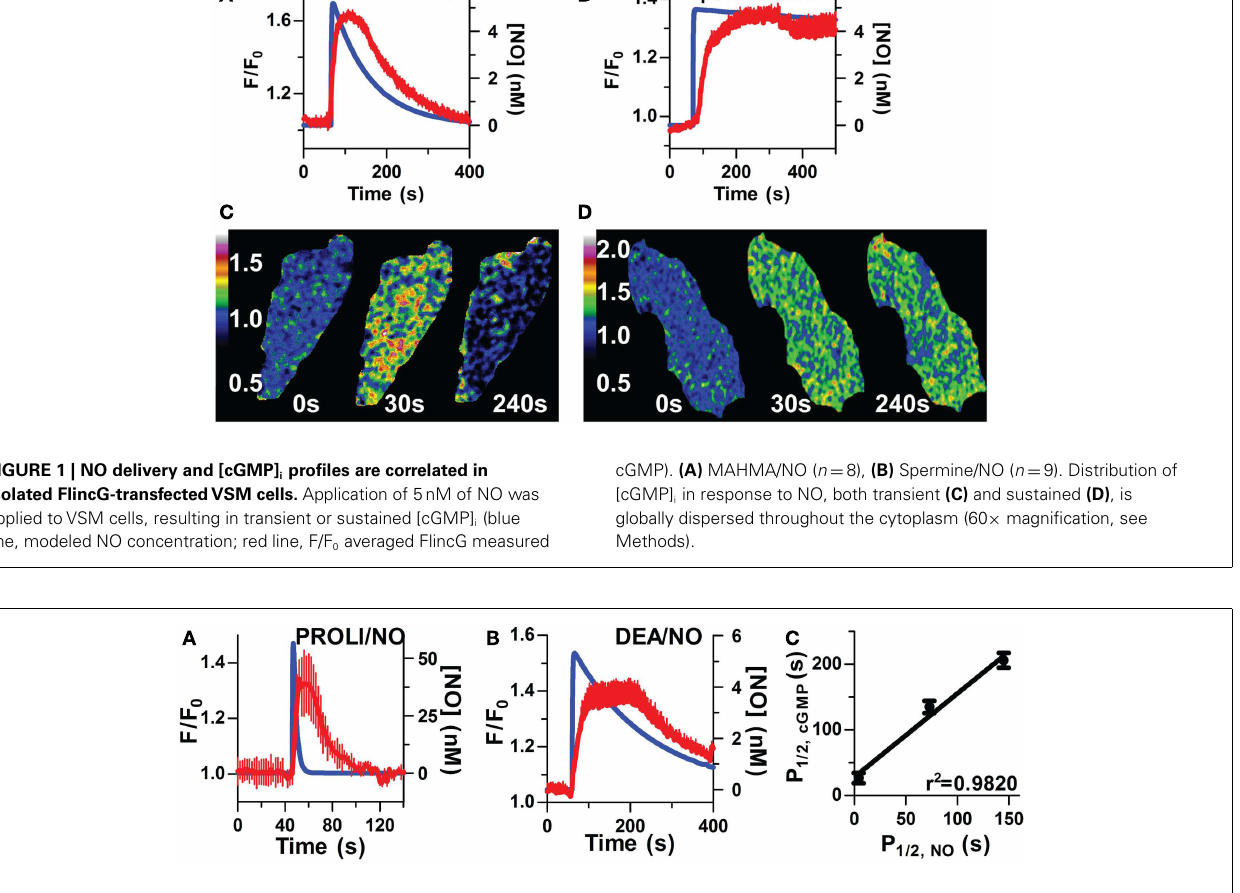
FIGURE 2 | Kinetic correlation of pulsed NO and [cGMP] i . Short half-life donors result in rapid NO (blue lines, modeled NO concentration) and cGMP peaks (averaged traces, red lines, n = 6) as depicted in (A ;